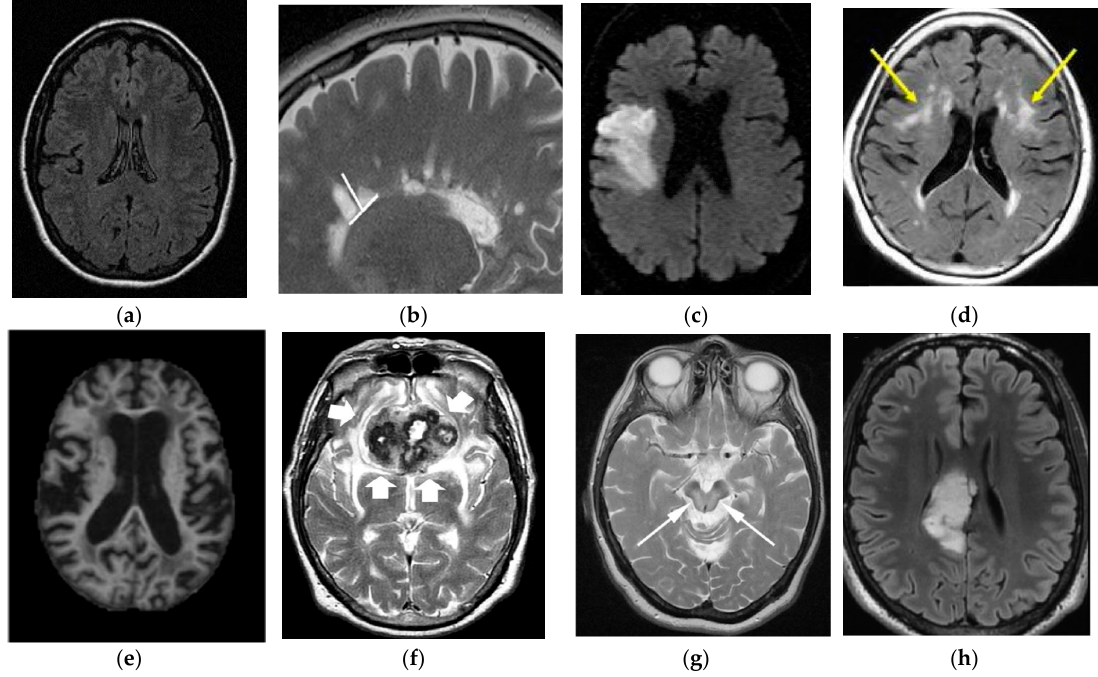
Figure 17. Comparison of brain tumor with other brain disorders (image permission requested from sources). ( a ) Normal Brain [AtheroPoint TM ]; ( b ) Multiple Sclerosis [113]; ( c ) Stroke [114]; ( d )